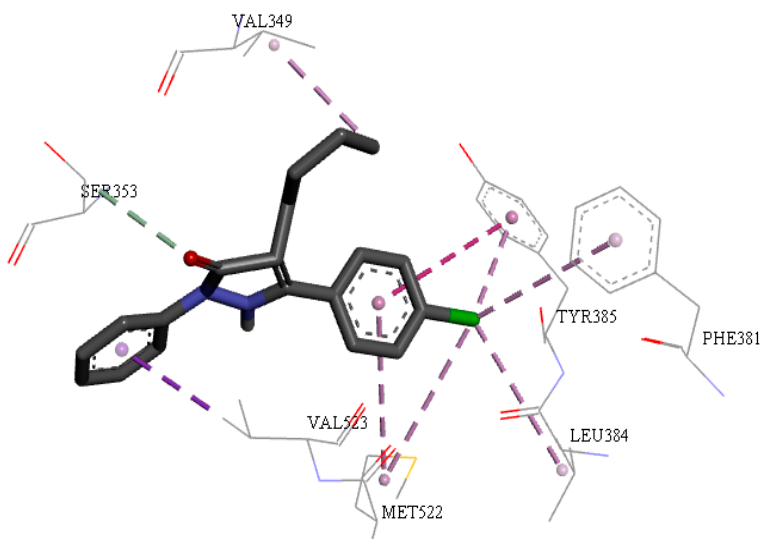
Figure 8. Interactions of structure between 14 and COX-2 of Mus musculus . Hydrophobic effect of alkyl or Pi-alkyl, Pi-sulfur, hydrogen bonds and Pi-Pi interactions are shown.